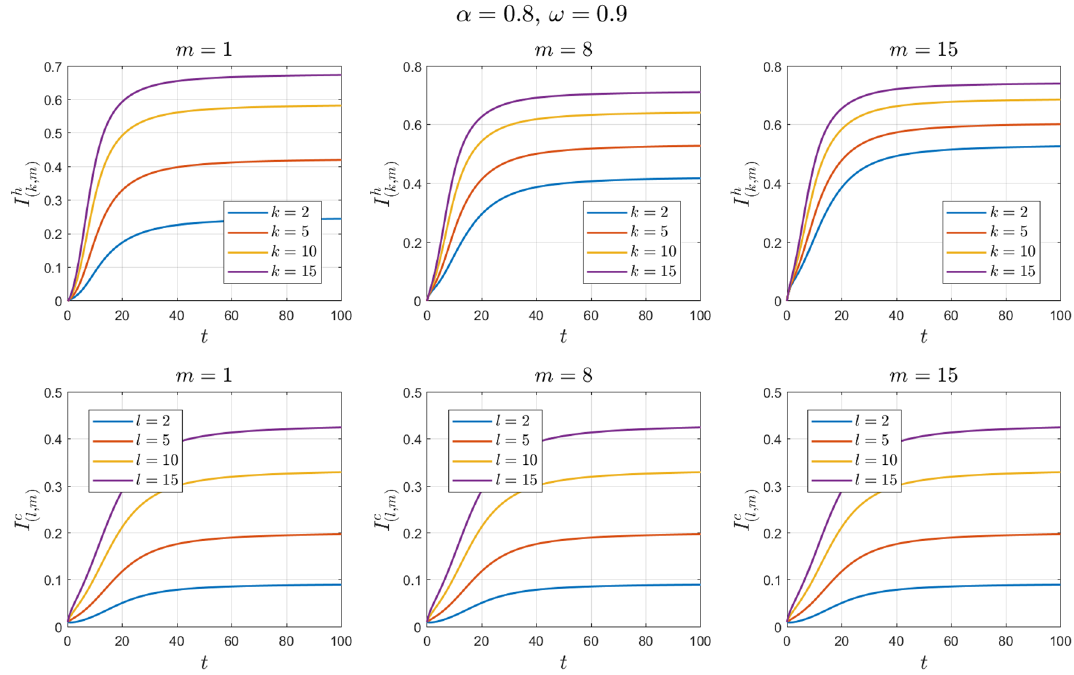
Figure 18. Numerical solutions of Example 5 for α = 0.8 and ω = 0.9 .